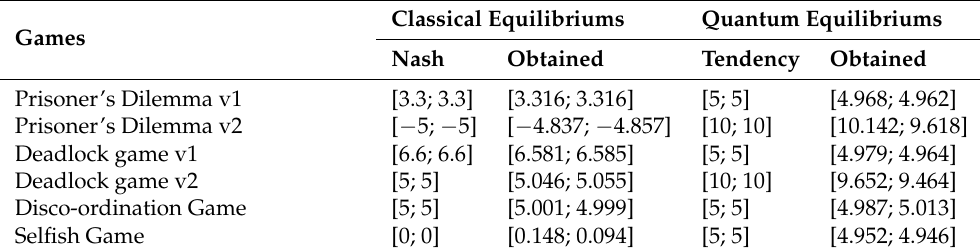
Table 5. Classical and Quantum performance of games after applying algorithm 1 (average rewards of the last 50,000